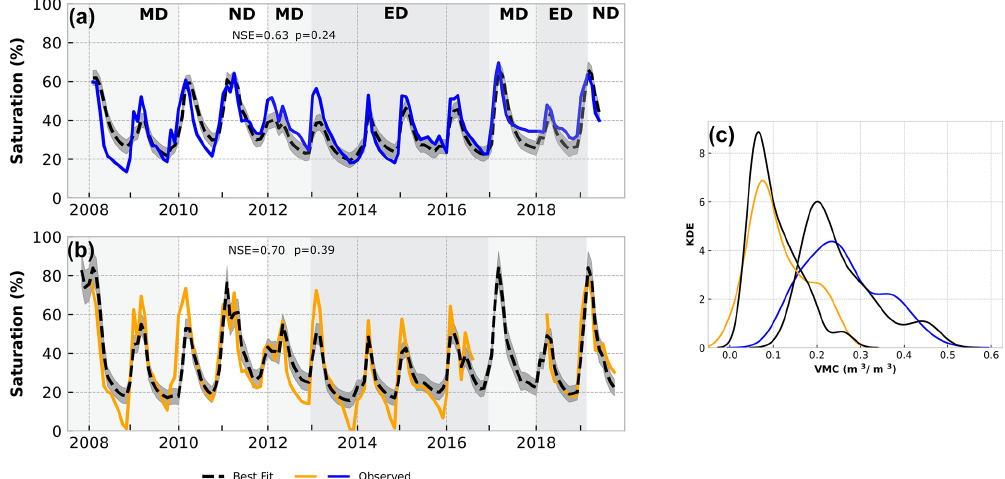
Figure 7. SMBM results for the (a) coastal and (b) inland sites. Observed soil moisture is indicated by a solid line (blue coastal, orange inland), while simulated moisture is shown with a dashed black line. Grey shaded banding indicates ± 1SD (standard deviation) based on the output of 1000 Monte Carlo simulations. Grey vertical shading indicates non-drought (ND), moderate drought (MD), and extreme drought (ED) periods. (c) KDE curves of the observed and simulated moisture for the best model fit confirm the functionality of the model. NSE and p values from Kolmogorov–Smirnov tests are indicated in panels (a) and (b) , indicating statistical similarity between observed and simulated